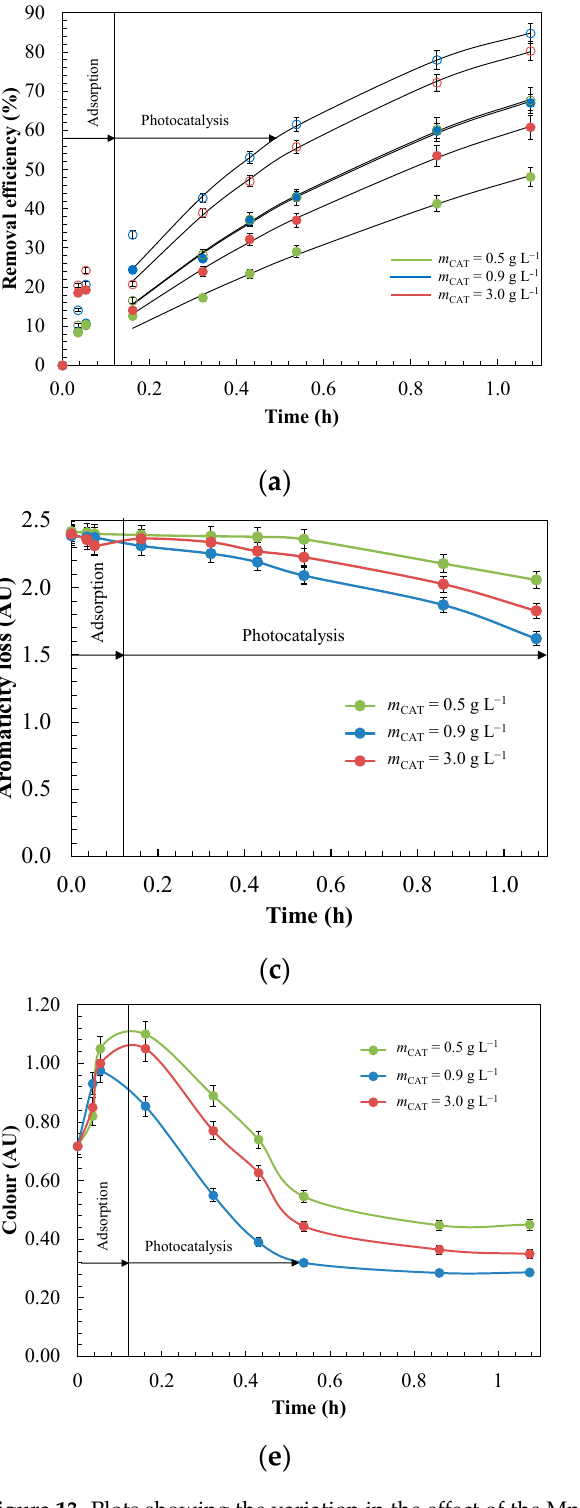
) and BTH ( • ) fitted to the (cid:35)